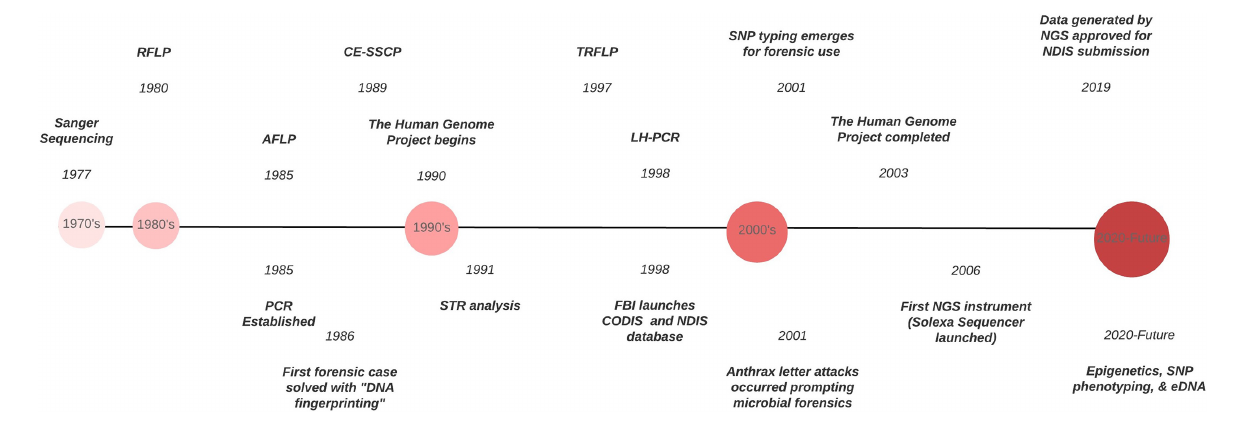
Frontiers in Ecology and Evolution |